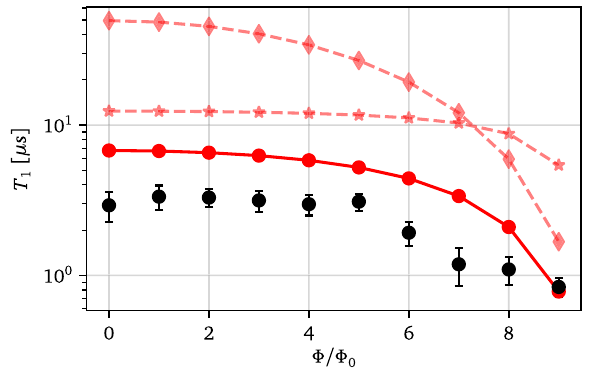
FIG. 6. Qubit relaxation time T 1 versus flux. Black points and error bars are the extracted values of T 1 from Gaussian means and standard deviations, respectively. The various types of red points correspond to computed values of Purcell-limited T 1 , assuming